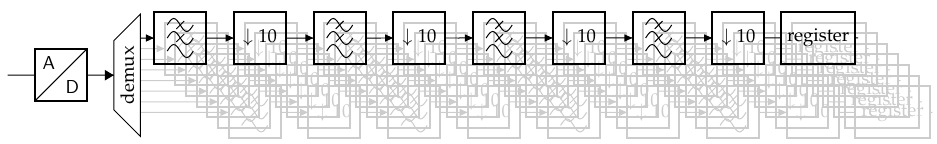
Figure 4. Schematic representation of the data processing and flow on the microcontroller of the Sylvatica board. The data coming from the analogue-to-digital converter ADC contains data from all channels. These samples are copied to new vectors by a “demultiplexer” (demux) to make the filtering faster. The filtering consists of a cascade of low-pass filters, followed by a decimation step of factor 10 to reduce the sample